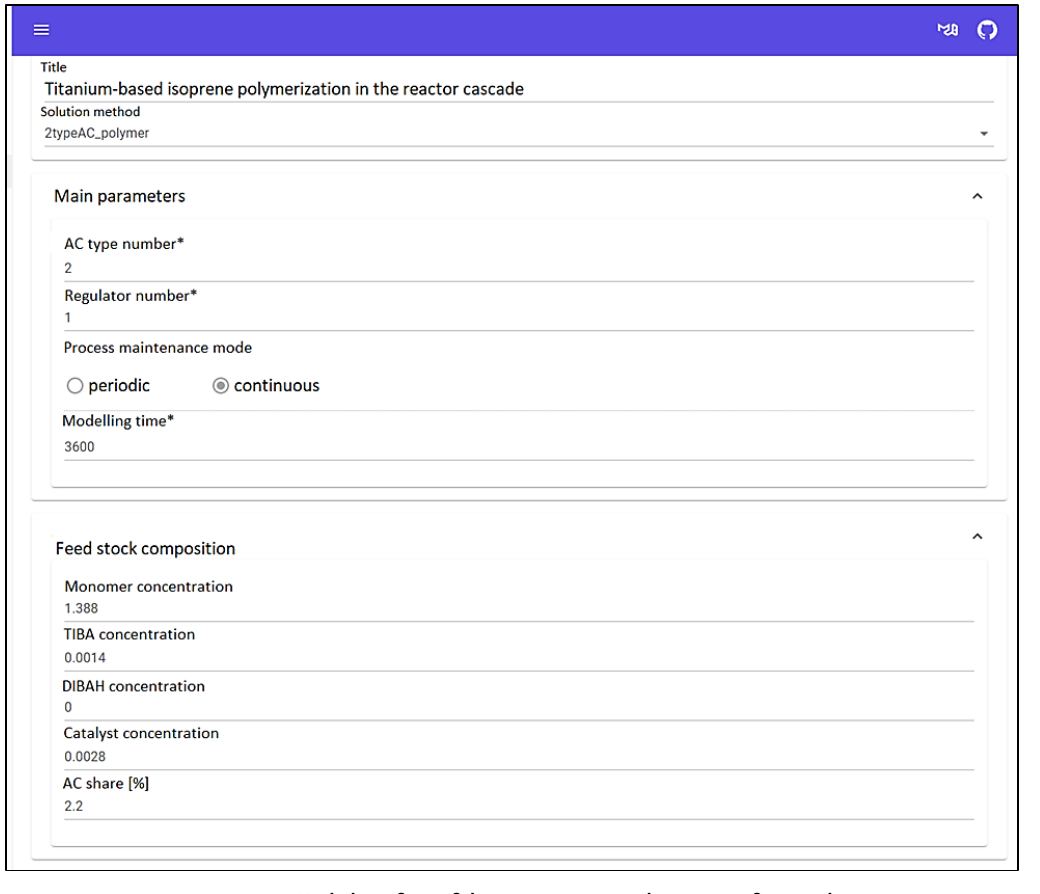
Figure 2. Web interface of the remote computing system